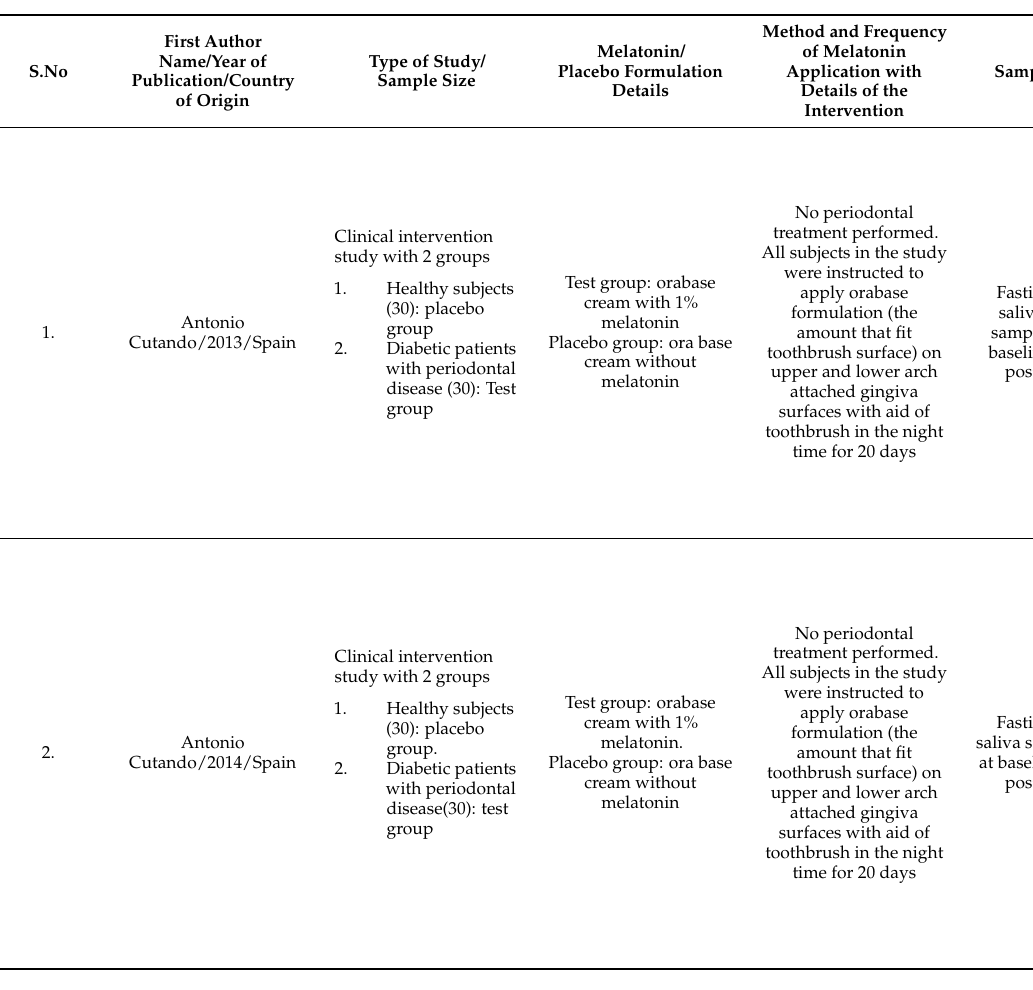
Table 2. Detailed data extracted from the included studies using topic melatonin